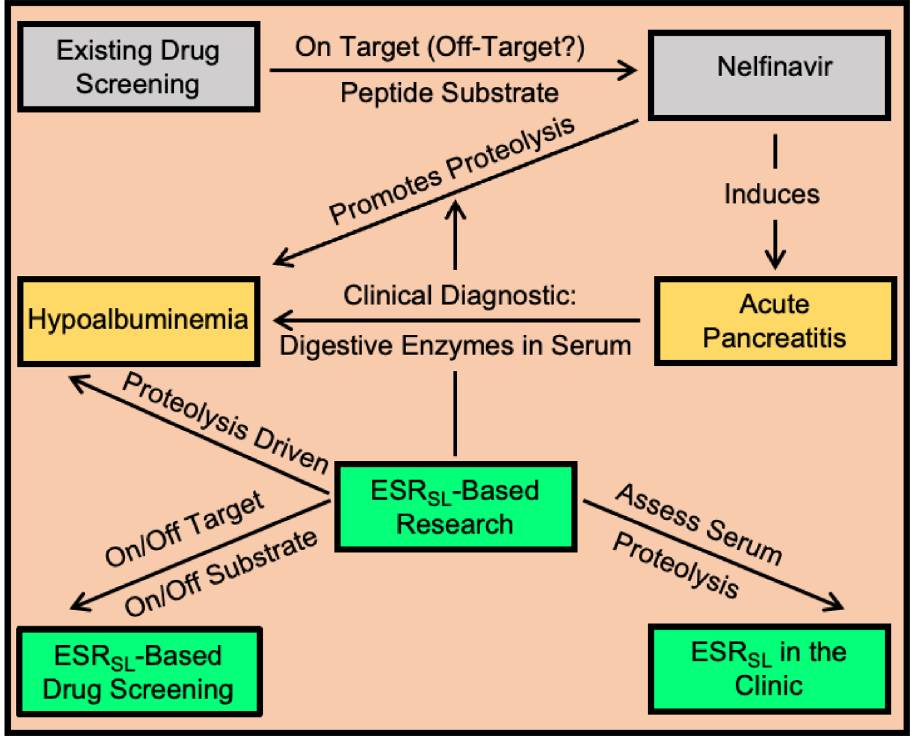
Figure 6. The shortcomings of existing drug discovery for protease inhibitors give rise to products such as nel fi navir, a putative HIV protease inhibitor. Nel fi navir is now known to induce acute pancreatitis and this work demonstrates that it promotes digestion of serum proteins, especially serum albumin, by digestive proteases. A diagnostic for acute pancreatitis demonstrates the presence of digestive enzymes in the serum. Taken together, it is postulated that the unspeci fi ed “ catabolism ” driver for hypoalbuminemia is proteolysis. The relative bene fi ts of ESR SL for drug screening and potential use in the clinic are